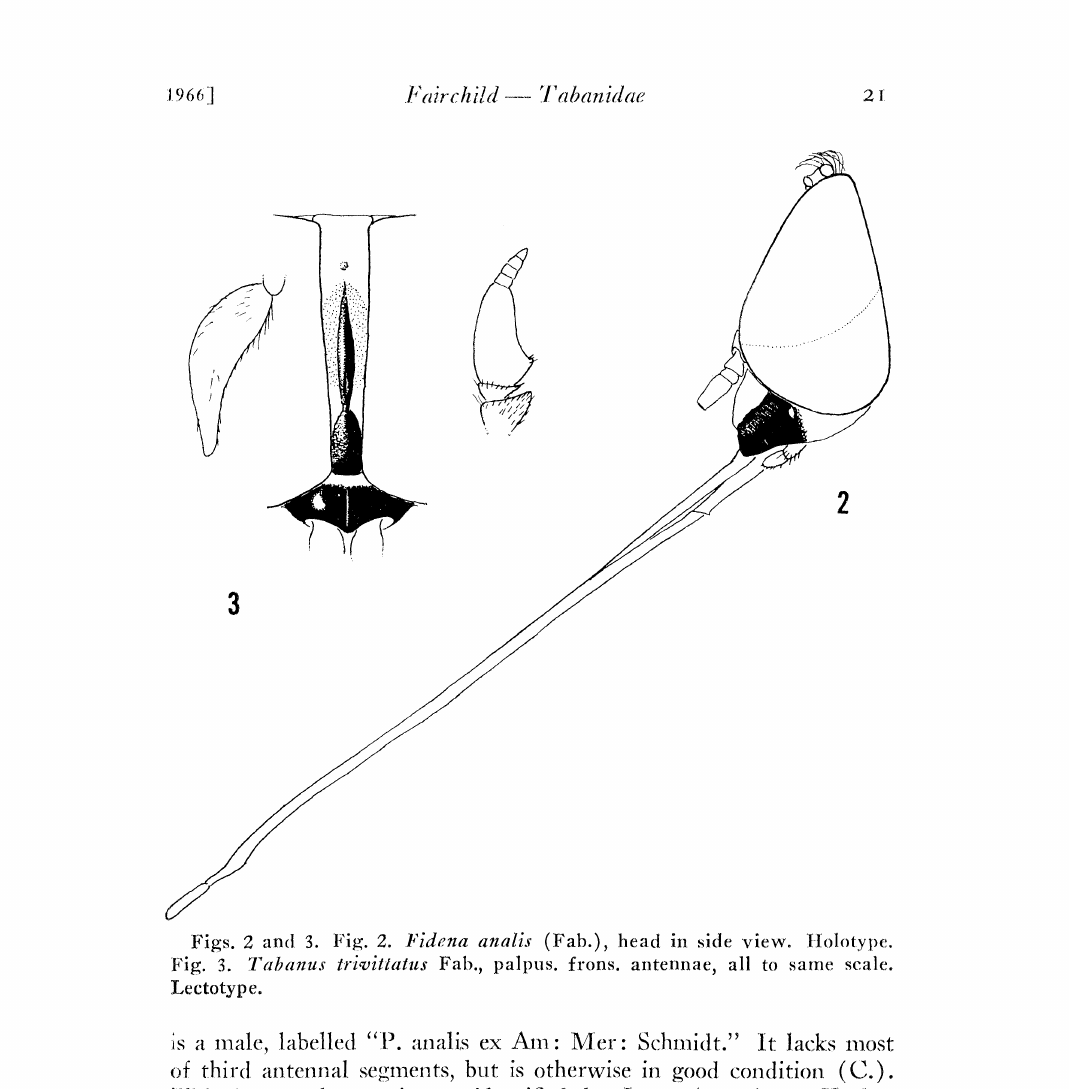
Figs. 2 and 3. Fig. 2. l"idena analis (Fab.), head in side view. Holotype. Fig. 3. Tabanus triviltatus Fab., palpus, frons, antennae, all to same scale. Le ctotyp